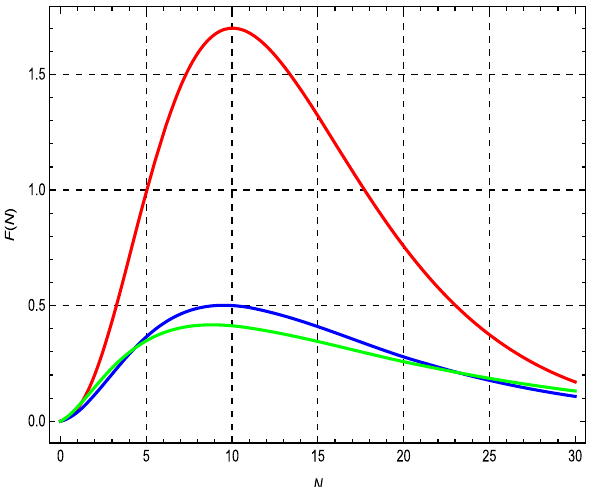
Fig. 2 Behaviour of the distribution function F ( N ) as a function of particle number N . Red, blue and green curves represent three different values for the correction parameter β 2 . Red curve is for β 2 = 0 (i.e. no GUP correction), blue for β 2 = 0 . 5, and green for β 2 =